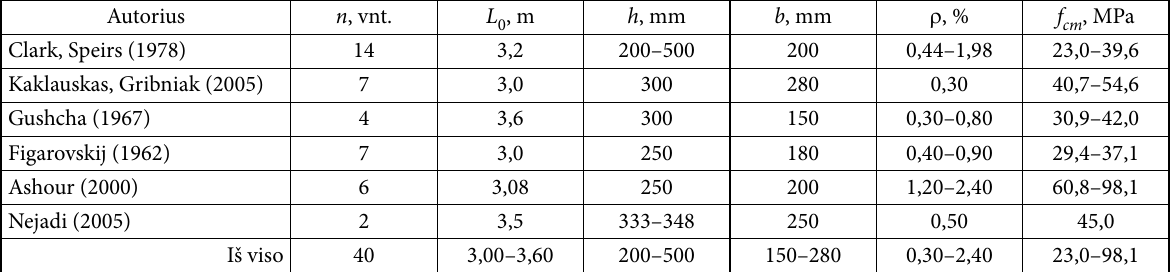
Table 2. The main characteristics of RC beams